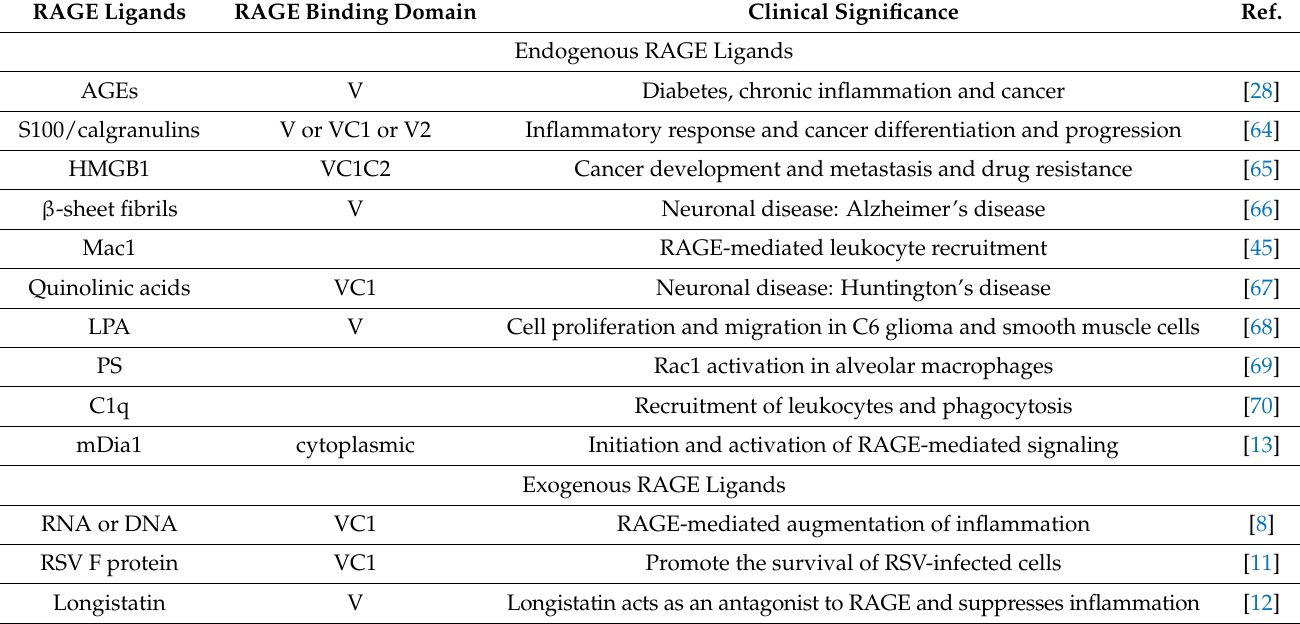
Table 1. Significant RAGE